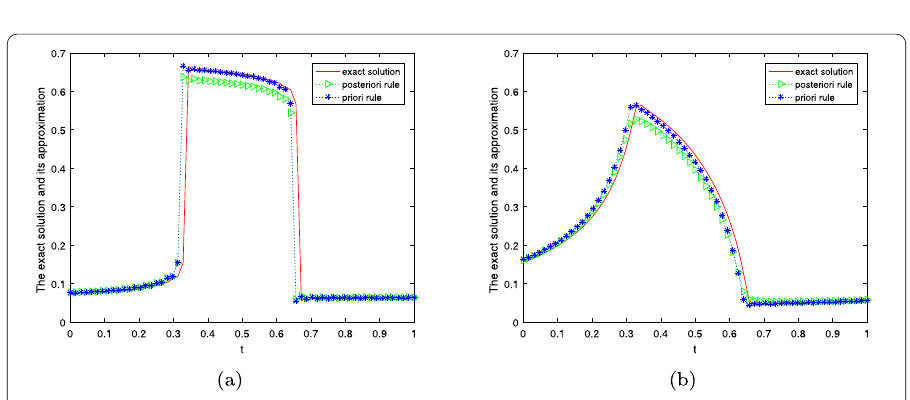
Figure 5 The comparison of the exact solution and its approximation solution for (cid:13) = 0.001 at x = 0.8 with Example 5.3, ( a ) α = 0.1, ( b ) α = 0.7